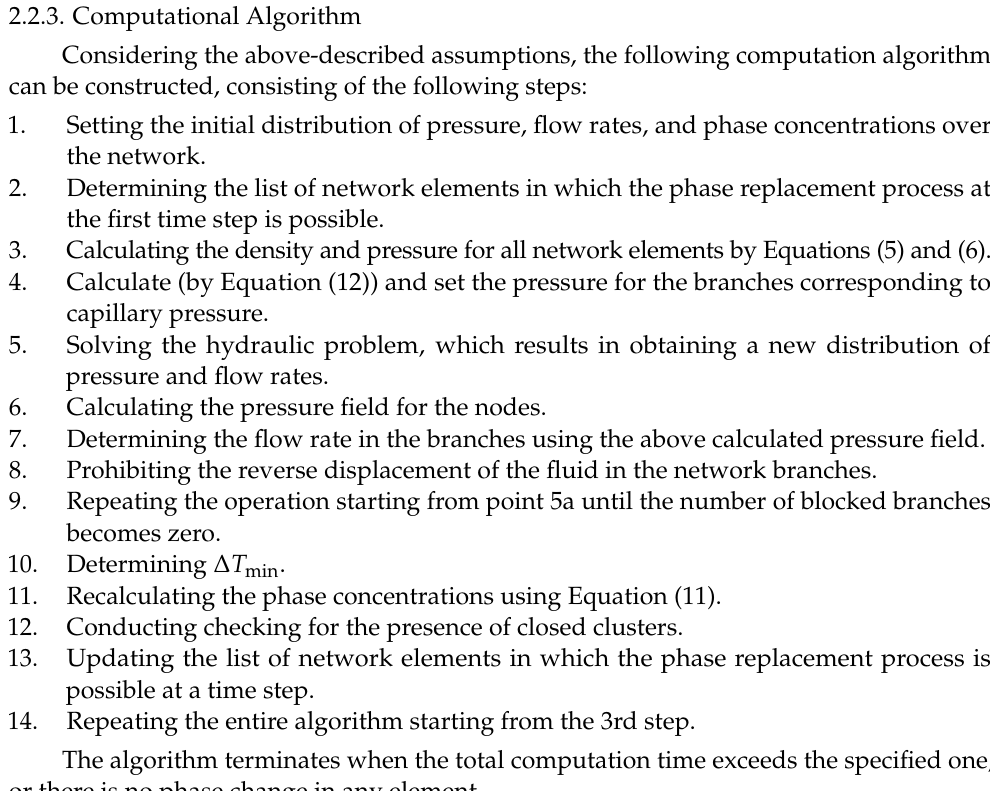
Figure 6. The defining of the capillary pressure. Color: green — oil, blue — displaced fluid.